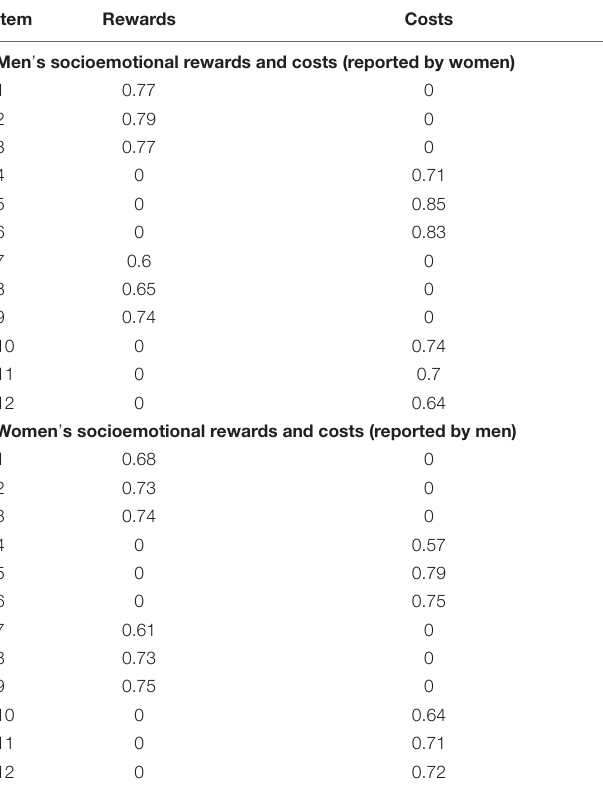
TABLE 5 | Correlations among total scores on narcissism scale and socioemotional reward and cost subscales in the main study (final N = 177 couples). a